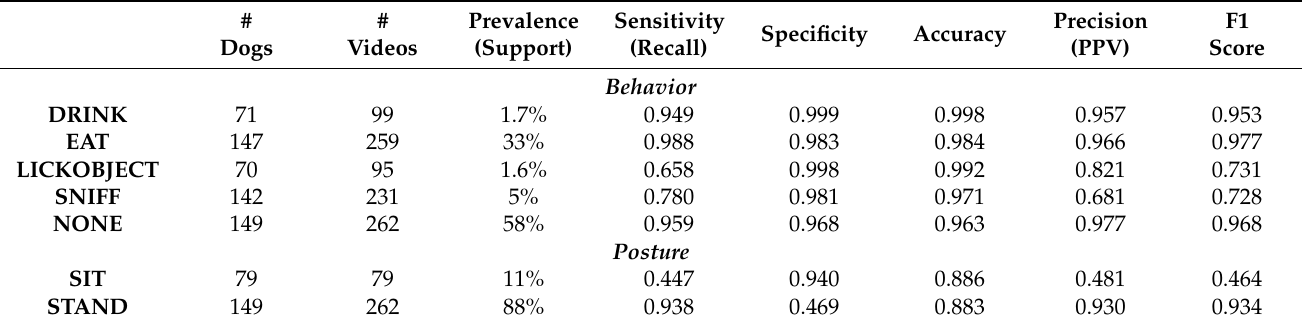
Table 7. Classification metrics for the eat/drink dataset